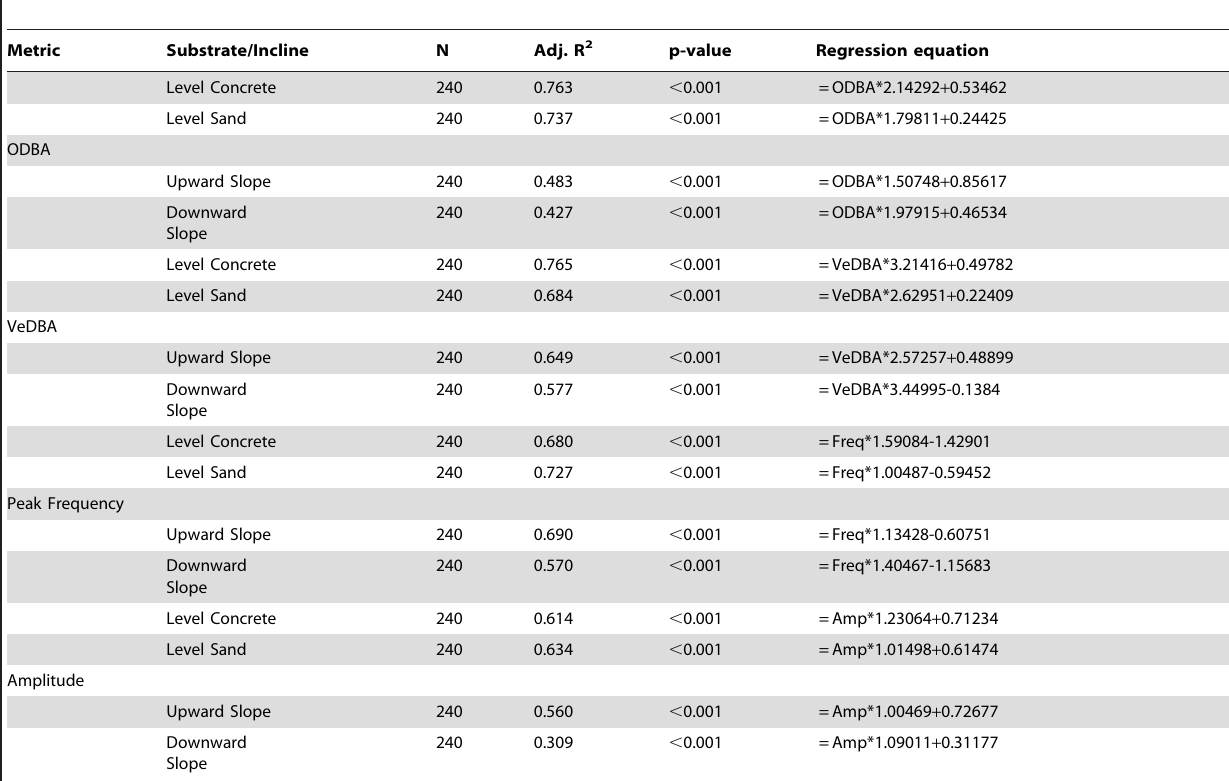
Table 3. Summary of the statistics for the regression between the metrics (VeDBA, ODBA, peak frequency, and amplitude) and speed, with substrate and incline conditions (Level Concrete, Level Sand, Upward Slope and Downward Slope) considered